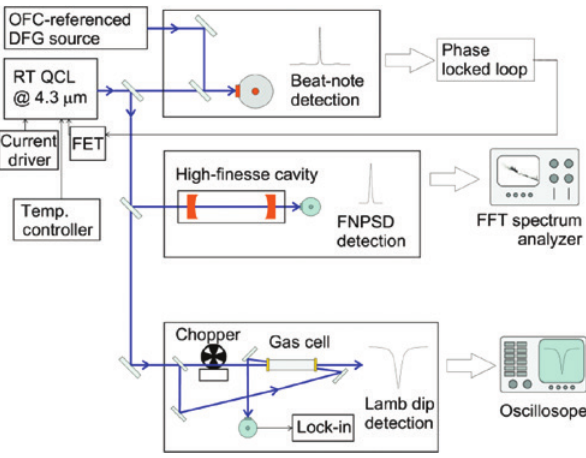
Figure 7: Schematic of the experimental setup. There are three main parts: the beat-note detection between QCL and DFG for the phase-locking, the high-finesse cavity for FNPSD analysis, and the saturation spectroscopy signal detection for the absolute frequency measurement of the CO transitions. Reprinted 2 with permission from [47], copyright 2013.